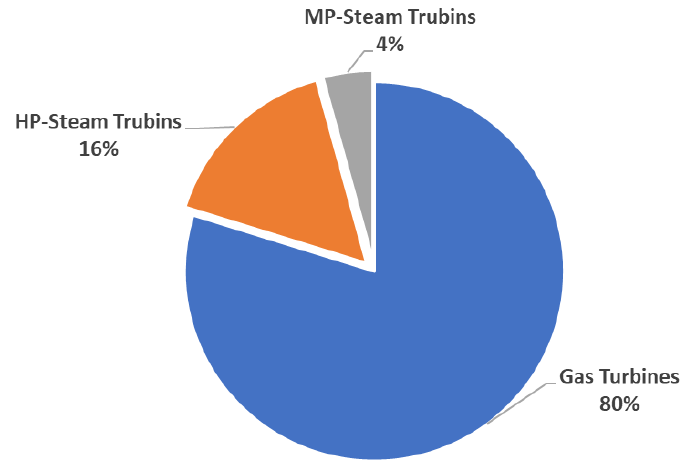
Figure 10. Distribution of the power generated by the equipment in the process.